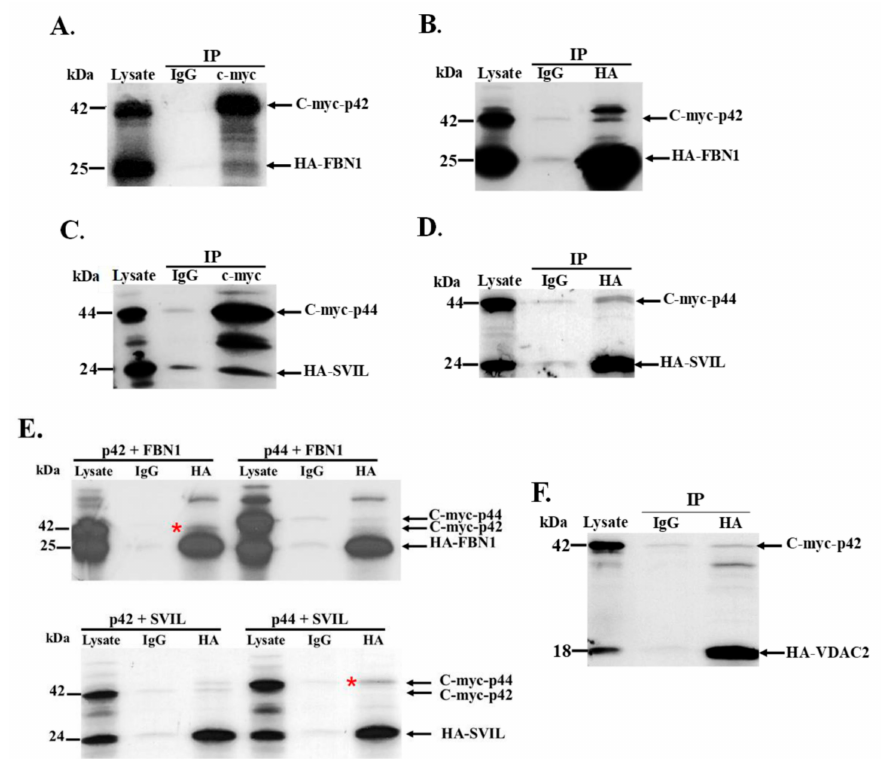
Figure 5. Analysis of the interaction between human OAS1 p42 and p44 isoforms and their respective binding partners in vitro. Wheat germ extract was used for the in vitro transcription and translation of c-myc tagged full length human OAS1 isoforms and of HA-tagged FBN1 (188 aa), SVIL or voltage-dependent anion channel (VDAC) peptides in the presence of [ 35 S]-methionine. Reciprocal pull-down assays were performed with anti-HA and anti-c-myc antibodies. Non-specific IgG was used as the negative control. The protein complexes were resolved by SDS-PAGE and detected by autoradiography. ( A ) HA-FBN1 peptide and full-length c-myc-OAS1 p42 immunoprecipitated with anti-c-myc antibody. ( B ) C-myc-OAS1 p42 and HA-FBN1 peptide immunoprecipitated with anti-HA antibody. ( C ) HA-SVIL peptide and c-myc-OAS1 p44 immunoprecipitated with anti-c-myc antibody. ( D ) C-myc-OAS1 p44 and HA-SVIL peptide immunoprecipitated with anti-HA antibody ( E ) (top panel) Either C-myc-OAS1 p42 or p44 and HA-FBN1 peptide immunoprecipitated with anti-HA antibody and (bottom panel) either C-myc-OAS1 p42 or p44 and HA-SVIL peptide immunoprecipitated with anti-HA antibody. The hOAS1 isoform specifically immunoprecipitated is indicated with a red asterisk. ( F ) C-myc-OAS1 p42 and HA-VDAC2 peptide immunoprecipitated with anti-HA antibody. IgG: non-specific antibody control; IP: